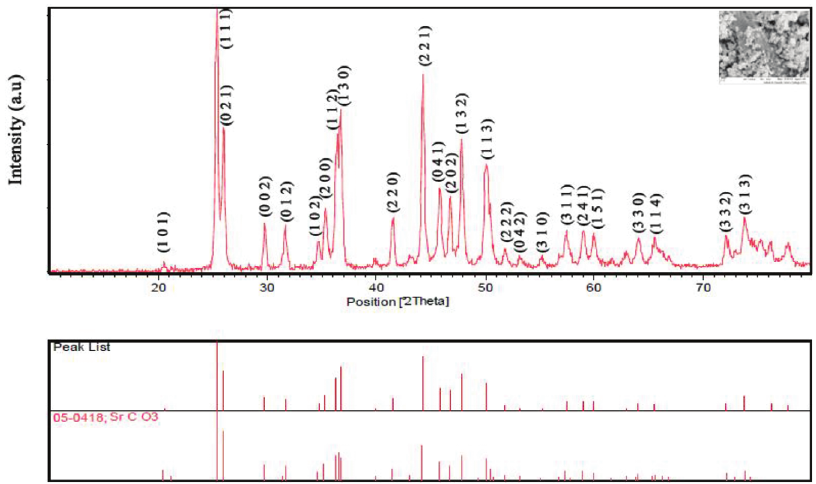
Figure 1: XRD of sample no. 11.